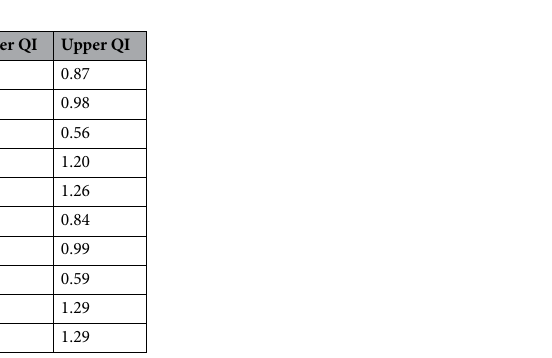
Table 2. Odds ratios of parameters for the full models (m3b) in the 2016/17 and 2017/18 NSW cohorts. Lower QI = lower bound of the 95% Bayesian quantile interval; upper QI = upper bound of the 95% Bayesian quantile